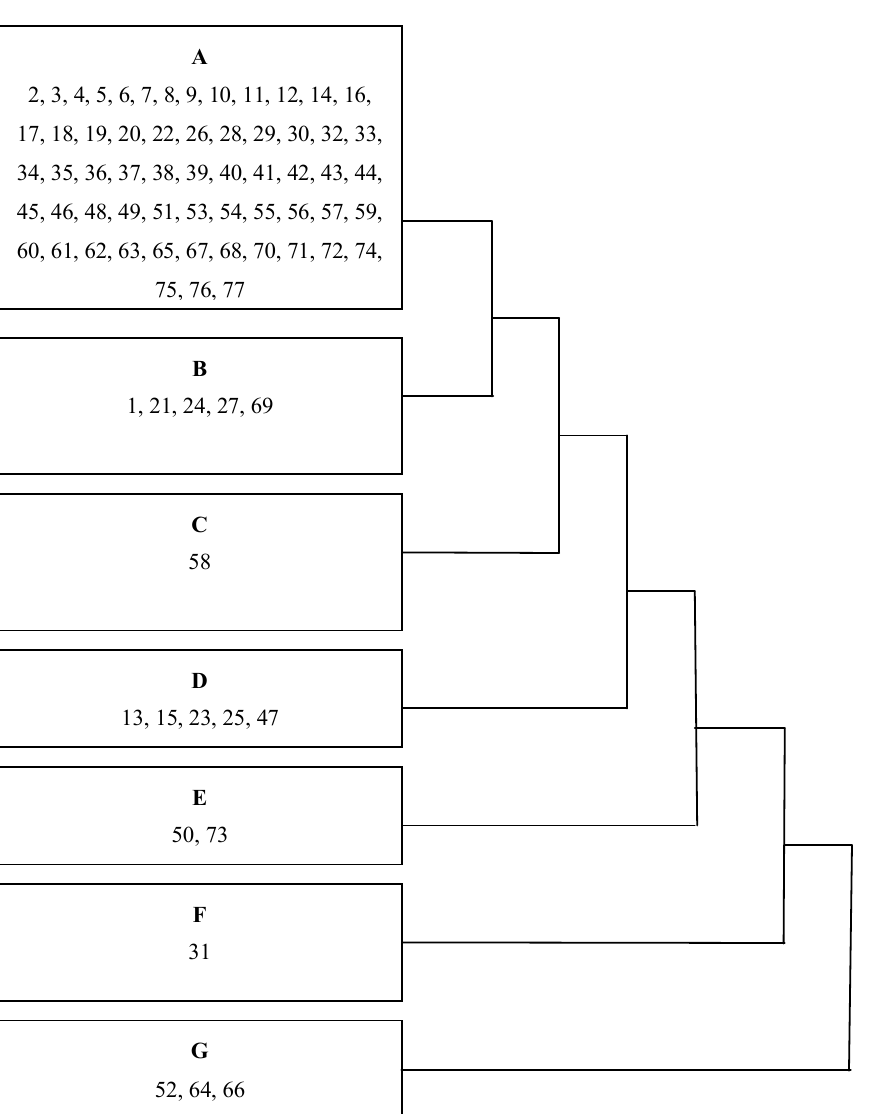
Fig. 2. Clustering result of container ports based on priori clustering